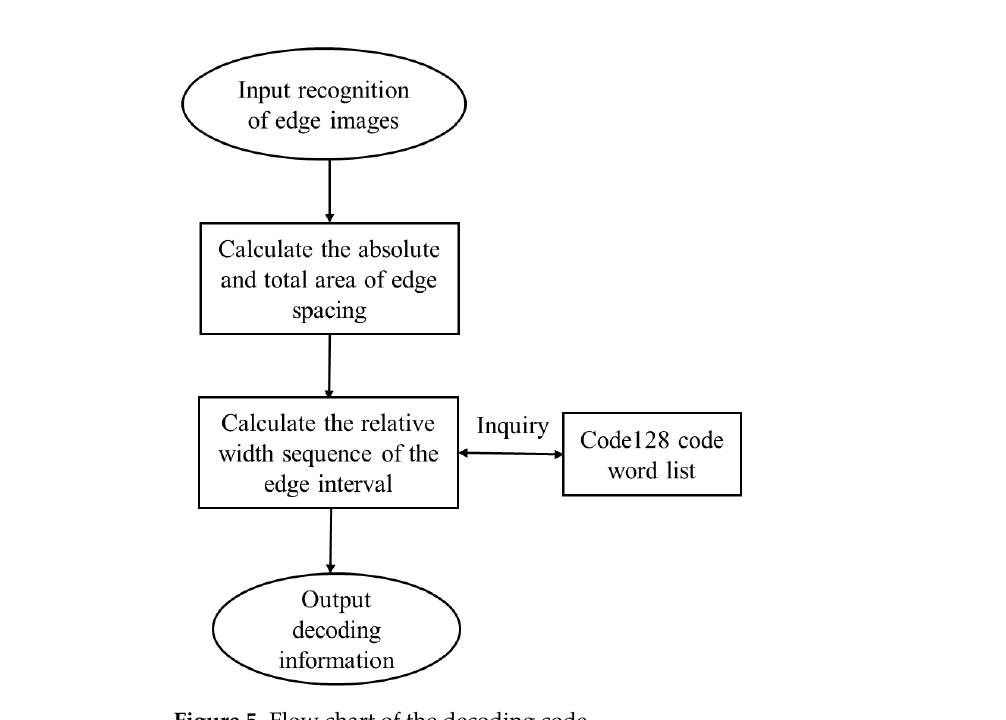
Figure 5. Flow chart of the decoding code.